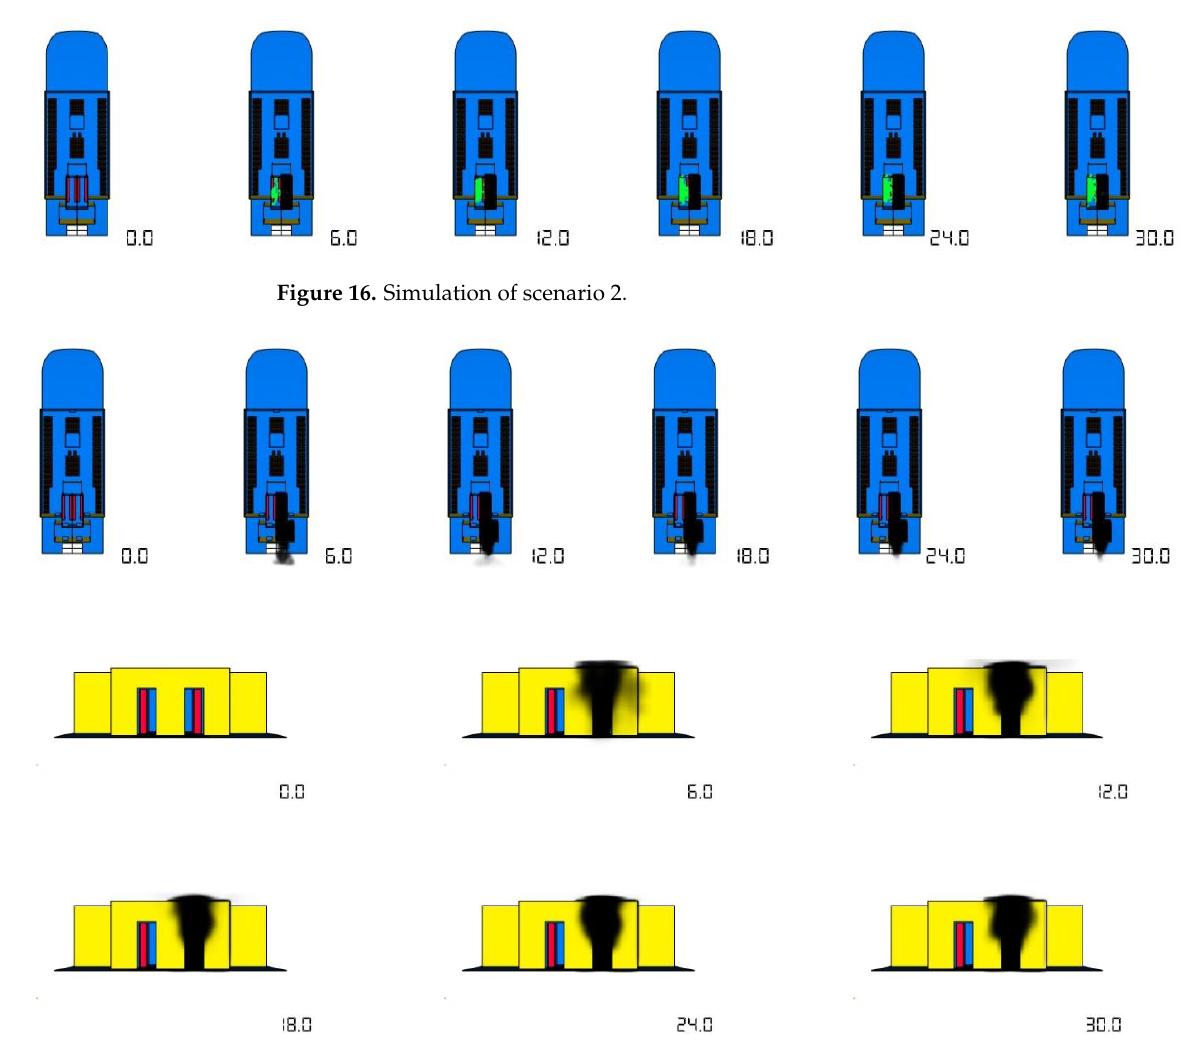
Figure 15. Simulation of scenario 1.